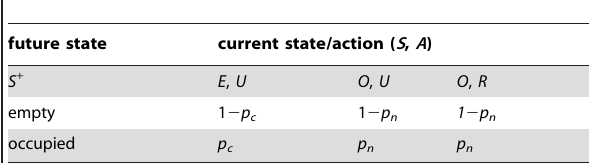
Table 3. Single site state transition when if p n = p s .